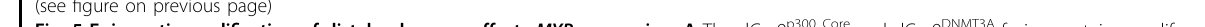
Fig. 5 Epigenetic modi fi cation of distal enhancers affects MYB expression. A The dCas9 p300 Core and dCas9 DNMT3A fusion proteins modify chromatin at a targeted enhancer. The region encompassing the HBS1L-MYB intergenic region on chromosome 6 (135,376,037 – 135,502,452; GRCh37/ hg19 assembly) is shown. gRNA target locations are indicated in blue with corresponding black numbers. ENCODE/Broad Institute H3K4me1 and H3K27ac enrichment signal in K562 cells is shown for comparison. Magni fi ed insets for the MYB enhancer and promoter regions are displayed below. B – E K562 cells were co-transfected with indicated dCas9 p300 Core , and gRNAs targeted to the each MYB promoter and enhancer region. Then expression levels of dCas9 p300 Core fusion protein were detected with Western blot ( B ); dCas9p 300 Core fusion protein ( C ) and H3K27ac ( D ) enrichment at indicated regions was detected using ChIP-qPCR, and MYB mRNA levels were determined using RT-qPCR ( E ). dCas9 p300 Core (D1399Y) contained a nonfunctional residue substitution at the acetyltransferase domain and was used as a negative control. F – I K562 cells were co-transfected with indicated dCas9 DNMT3A fusion protein, and gRNAs targeted to the each MYB promoter enhancer region. Then expression levels of dCas9 DNMT3A fusion protein were detected with Western blot ( F ); dCas9 DNMT3A fusion protein ( G ) and 5-methylcytosine ( H ) enrichment at indicated regions was detected using ChIP-qPCR, and MYB mRNA levels were determined using RT-qPCR ( I ). dCas9 DNMT3A (ANV) contained a nonfunctional residue substitution at the DNA methylation domain and was used as a negative control. Data are represented as mean ± SD of three independent experiments, and P values are calculated using Student ’ s t-test (* P < 0.05; ** P < 0.01; *** P < 0.001) in ( C – E , G – I